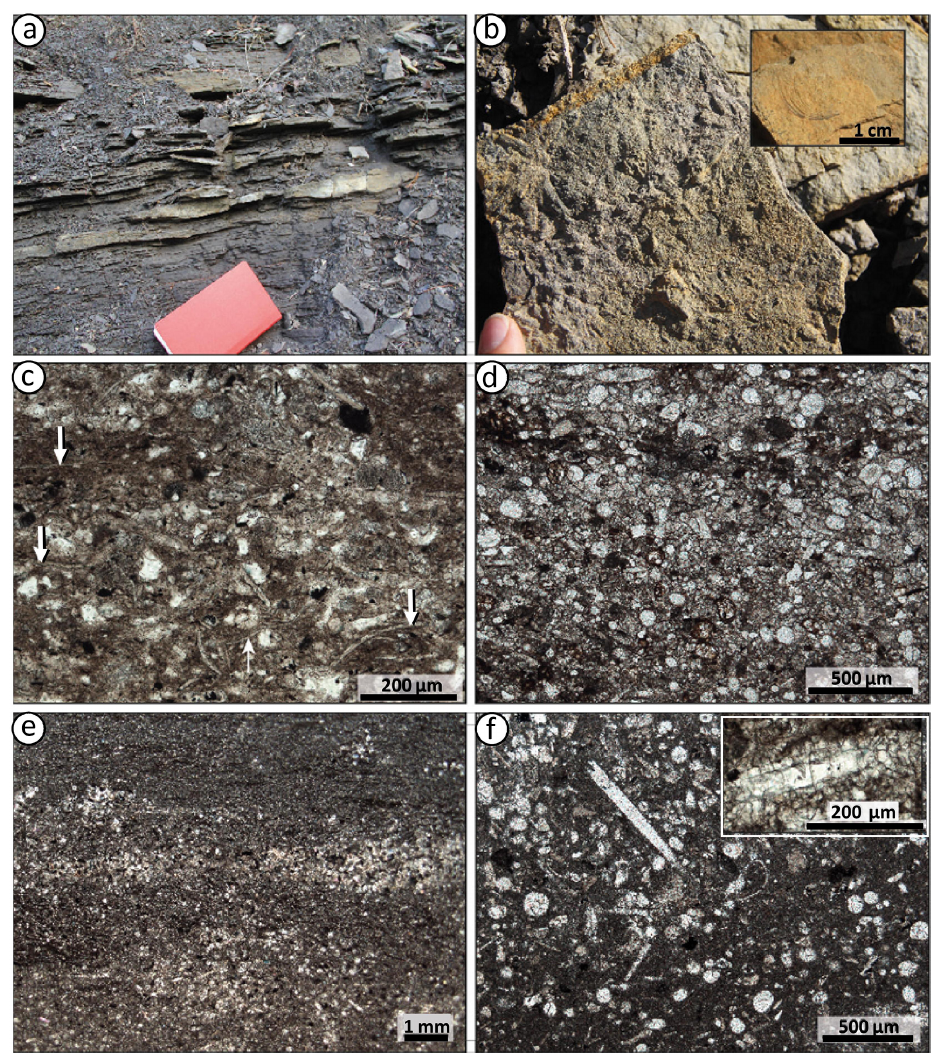
Figure 4. Background Facies 1 (F1). (a) Typical alternation between marl and limestone showing platy bedding. (b) Basal surface of a limestone slab with radiating burrow ( Gyrophyllites multiradiatus ); the inset shows the bivalve Bositra , the only common fossil in F1. (c) Marl with numerous filamentous structures (white arrows) interpreted as disaggregated Bositra shells. (d) Limestone showing the same microfossil content as the marl but in microsparitic matrix. (e) Limestone consisting of alternating packstone and wackestone laminae. (f) Marl with numerous recrystallized microfossils in a micritic matrix; circular objects are interpreted as calcispheres or radiolarians; the inset shows a tubular structure interpreted as a sponge